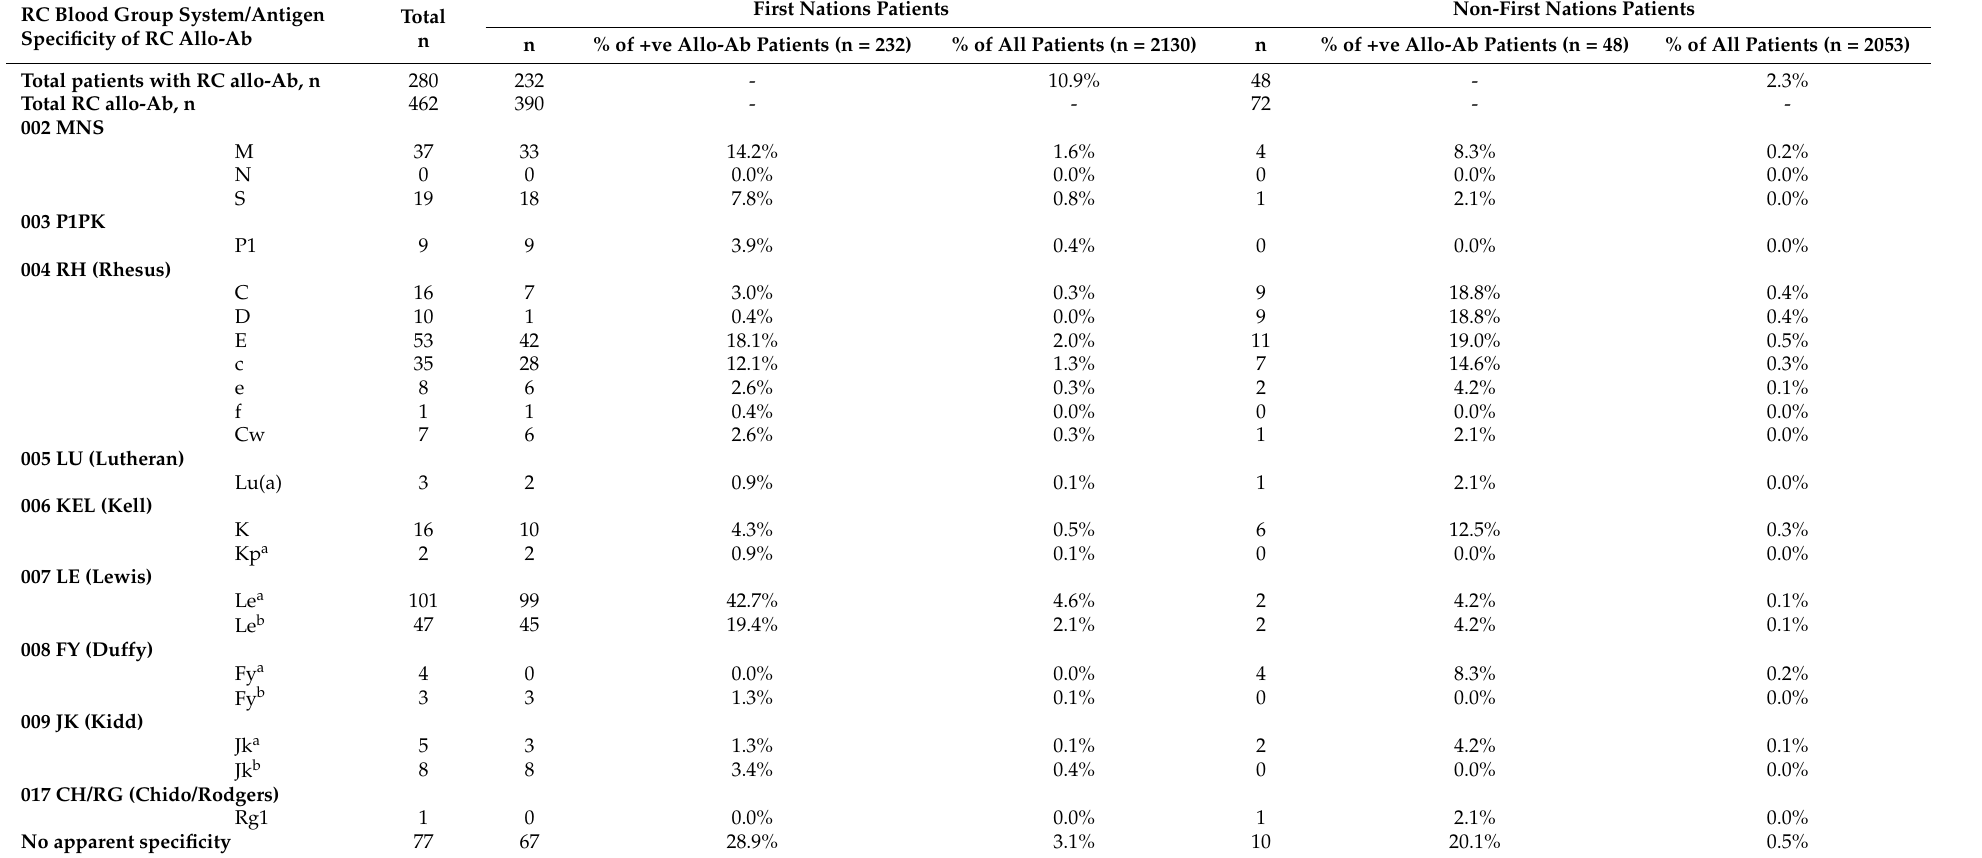
Table 4. Specificities of prevalent RC alloantibodies across entire study period by First Nations